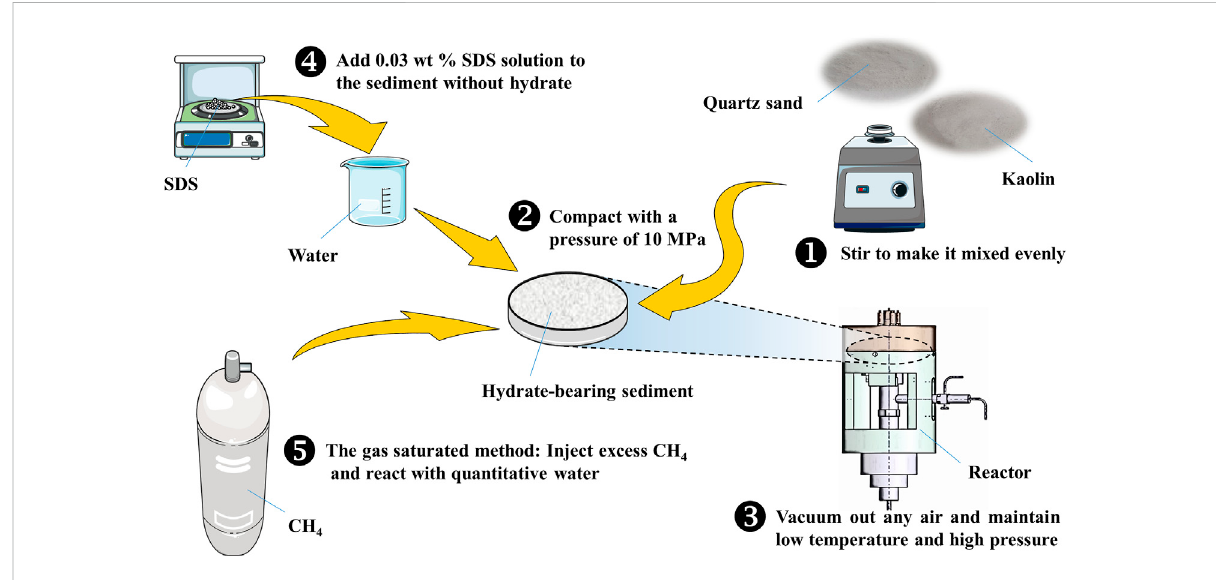
FIGURE 6 The experimental fl ow of gas hydrate-bearing sediment